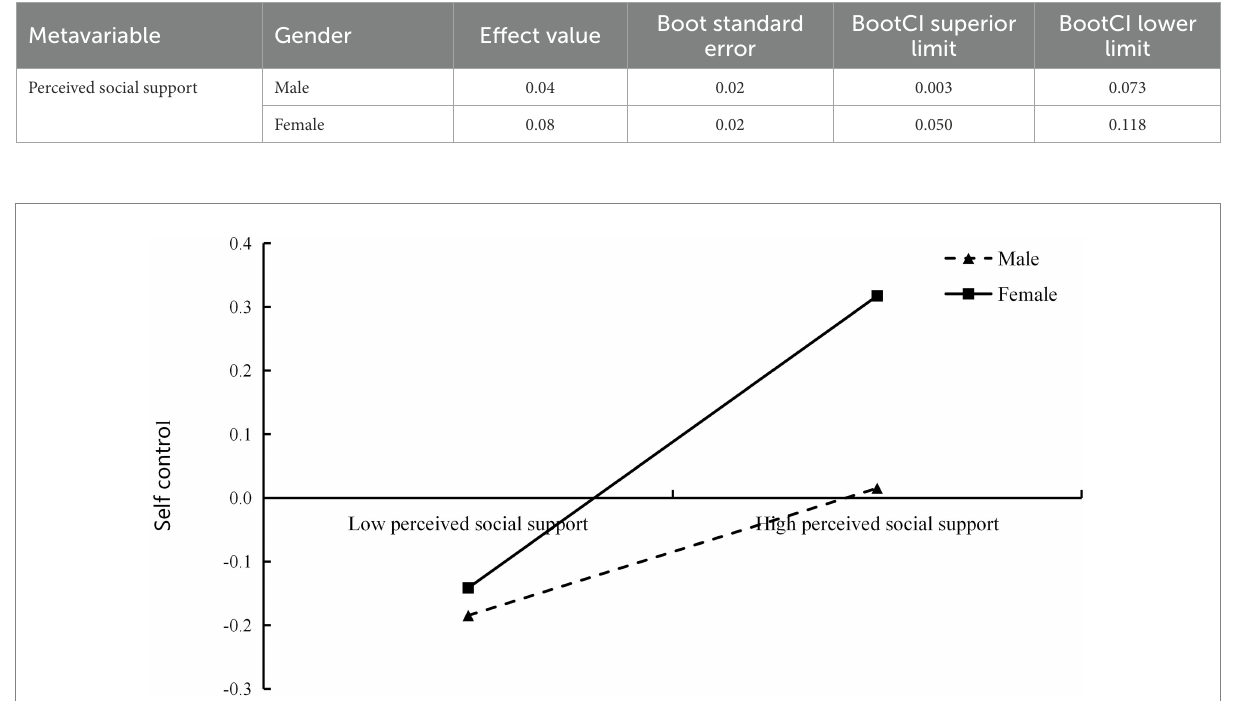
FIGURE 2 The moderating role of gender in perceived social support and self-control.